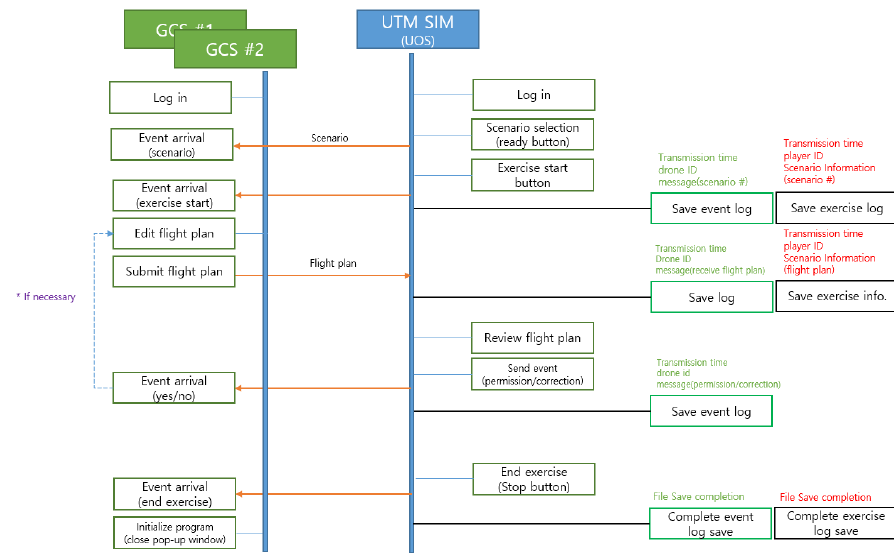
Aerospace 2021 , 8 , x FOR PEER REVIEW